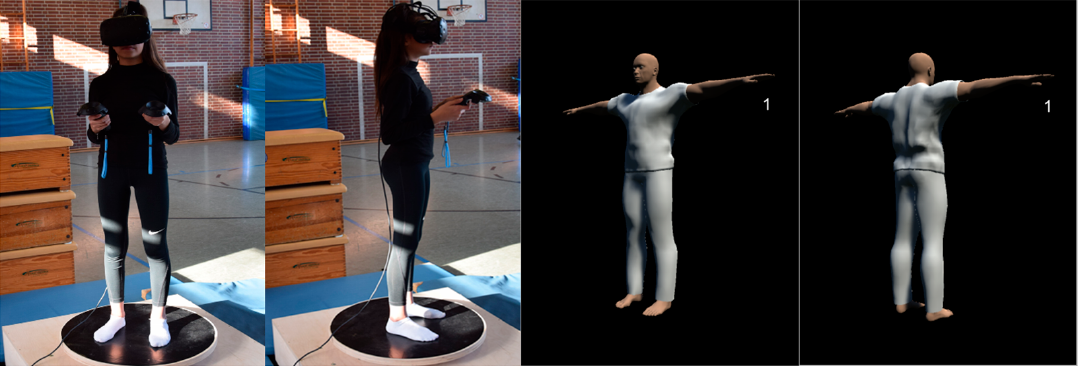
Figure 1. The experimental setup and the VR avatar. The two pictures on the left show a participant standing, i.e., rotating, on the turntable while wearing VR glasses and holding the controllers in her left and right hand. The two pictures on the right exhibit the avatar that the participant sees through the VR glasses in two different positions, i.e., during rotation.